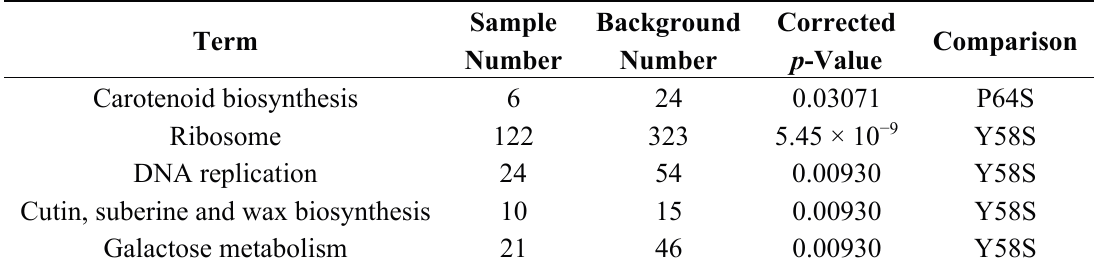
Table 2. The significantly enriched pathway terms in the RNA-Seq analysis. Term